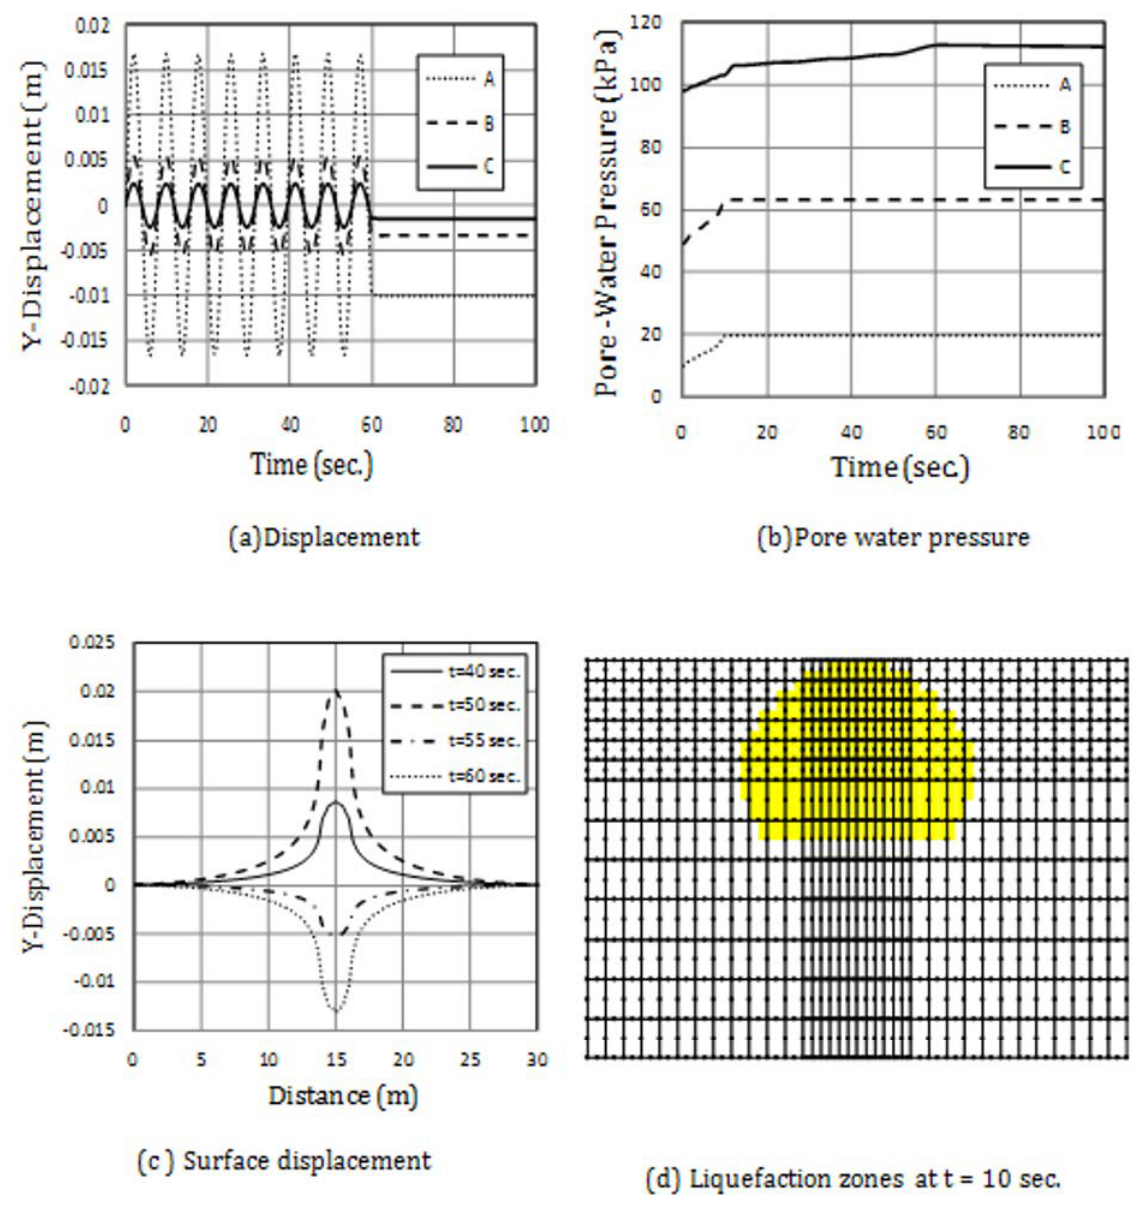
Figure 17. Dynamic response of the foundation to harmonic load, a